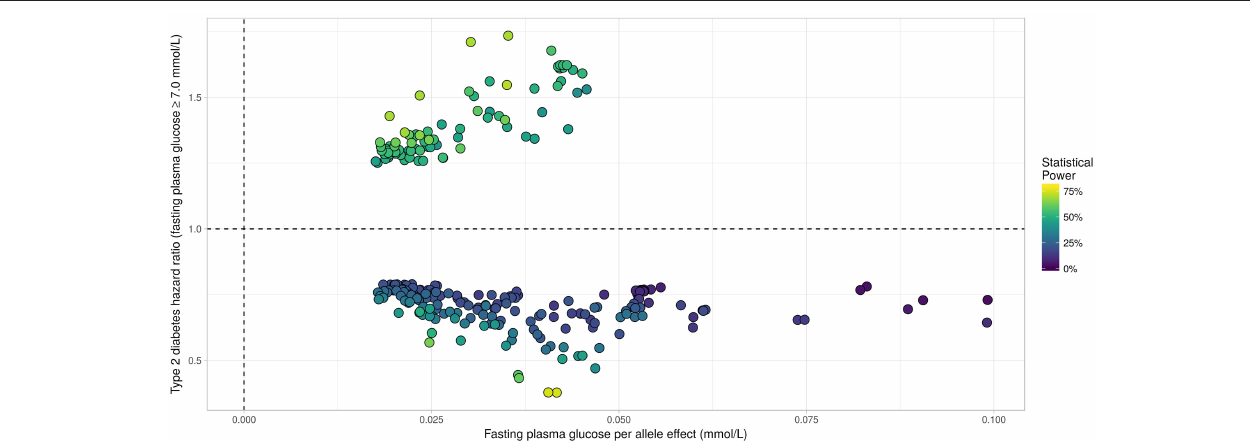
FIGURE 6 | Results from statistical analysis using “JM” (Rizopoulos, 2010, 2017), using fasting plasma glucose increasing allele as effect allele. Estimated effects of γ are displayed on the x-axis, with corresponding estimated hazard ratio exp ( α ) on the y-axis. Statistical power reported is the theoretical (retrospective) power to detect a genetic joint effect βγ + α based on estimated model parameters ( Chen et al., 2011).